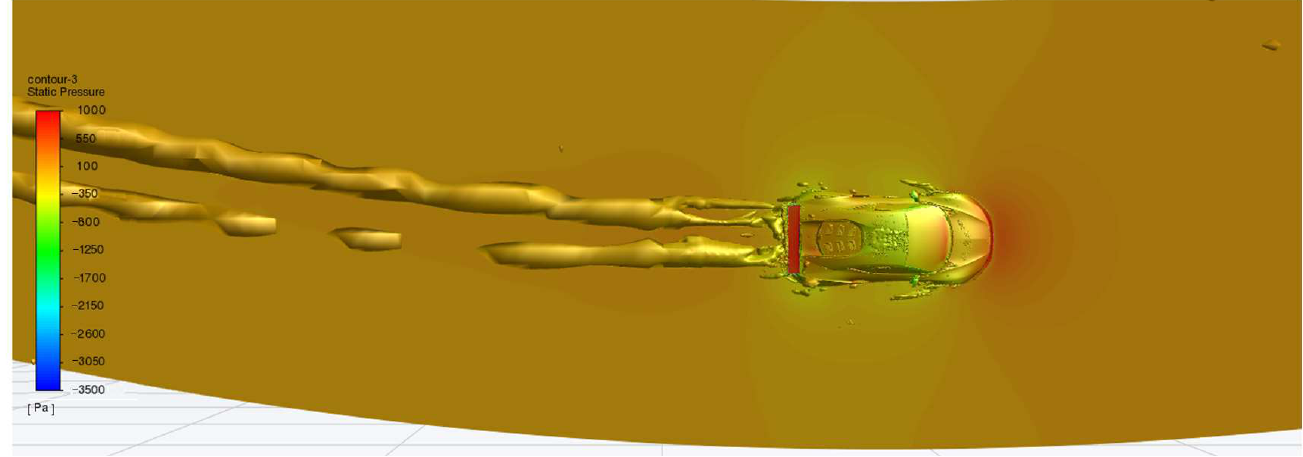
Figure 26. Influence of the supporting plate angle and wing twist angle-cornering.